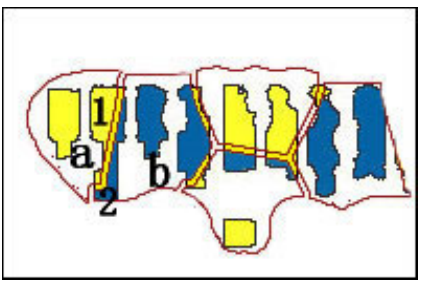
Figure 7. Division of typification areas of buildings.